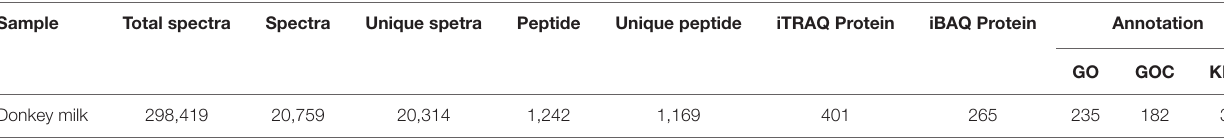
TABLE 3 | Statistics of the basic information on the identification of donkey milk